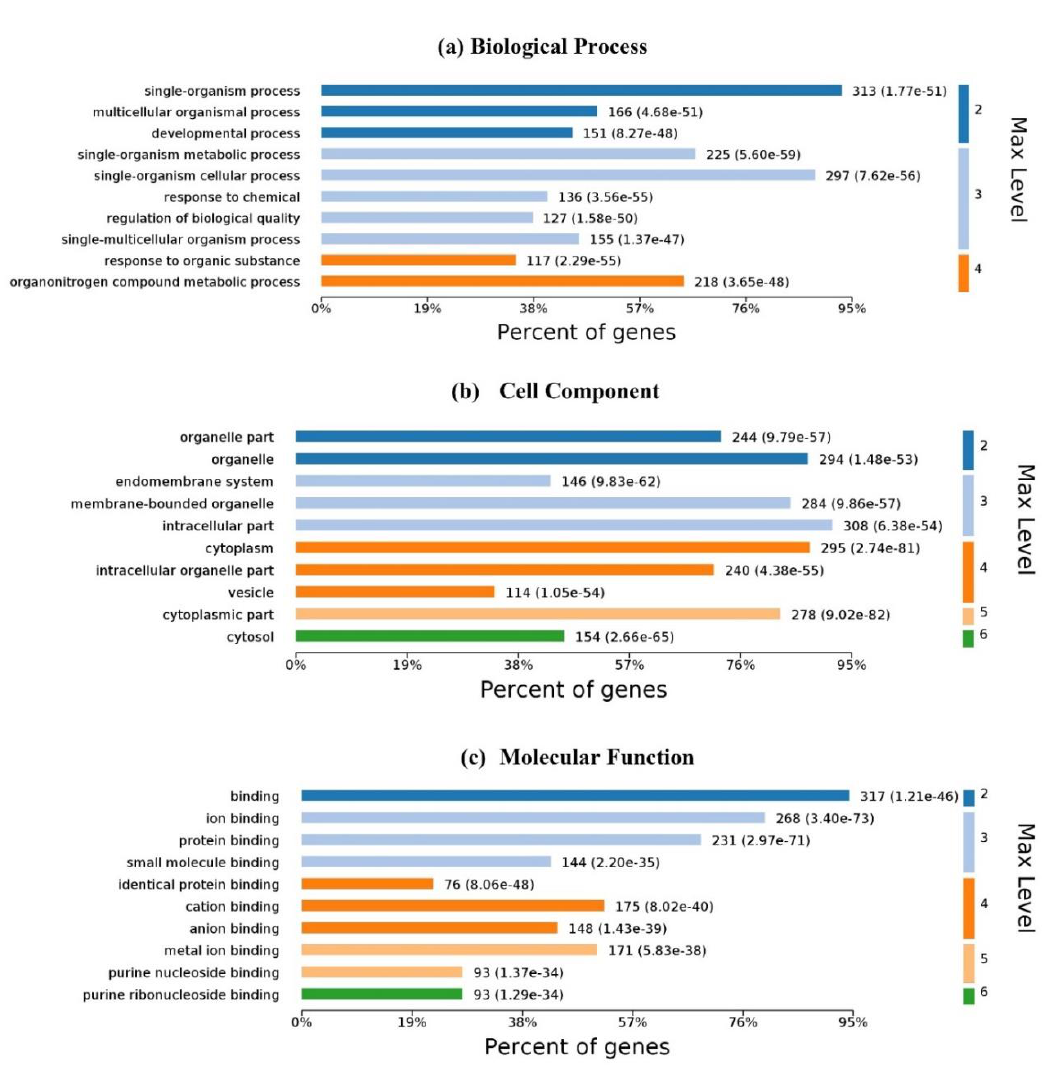
Figure 6. Gene ontology enrichment of Homo’s ligand-binding proteins: ( a ) biological process enrichment; ( b ) cell component enrichment; ( c ) molecular function enrichment. The graphs were made with OmicsBean.